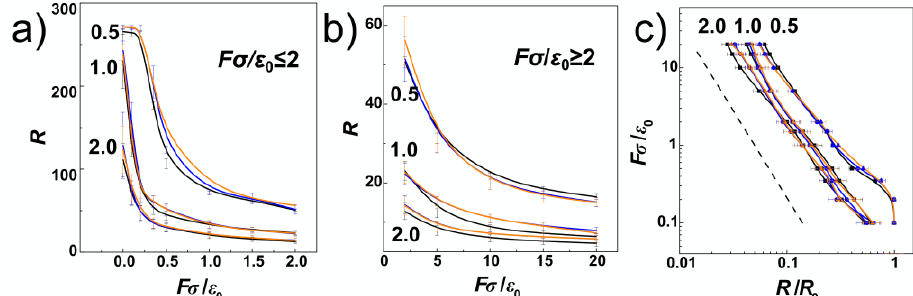
Figure 5. The evolution of polymer metrics during compression of DNA in helical and cylindrical nano-channels. In the plots, the black lines correspond to cylindrical channels, blue lines and orange lines to helical channels with negative −ω and positive + ω handedness respectively. The regime in terms of confinement strength expressed as the ration D/P = 0.5, 1.0 and 2.0 is indicated by numbers along the computed values of the span. Panels ( a , b ) show average extension of the DNA, R , for weak F σ / ε 0 ≤ 2 and strong F σ / ε 0 ≥ 2 compressive forces respectively. ( c ) Plot shows the extension of the DNA in log-log scale, while the dashed line corresponds to the theoretically predicted relation R ≈ F Y , where Y = −9 /4.